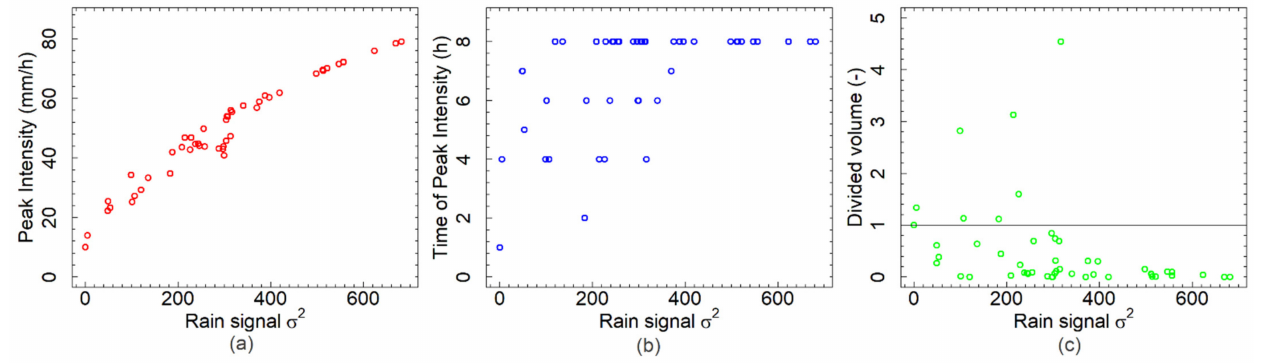
Figure 4. Peak intensities ( a ), time of peak intensity ( b ) and the first half volume of each rain divided by the second half volume of the rain ( c ), for all 50 rain signals used in this study.